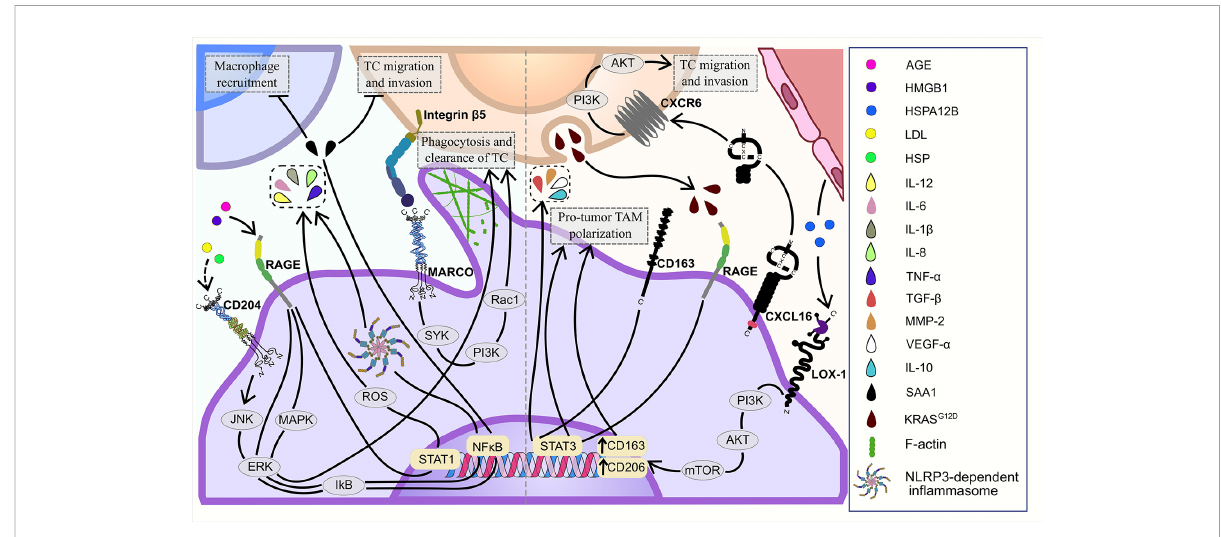
FIGURE 4 Major signaling pathways of TAM-expressing scavenger receptors in the TME: tumor-supporting and